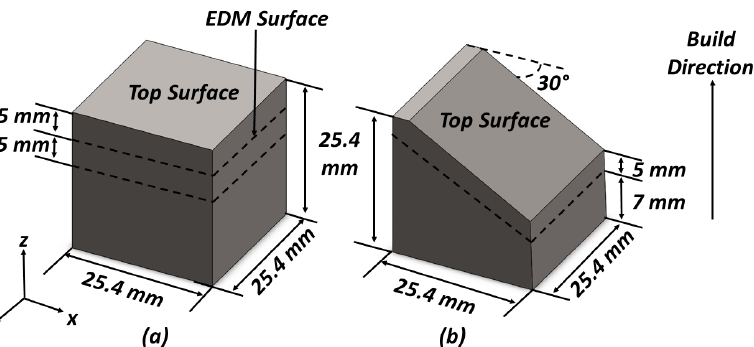
Figure 1. Schematic of the samples: ( a ) Sample 1 and ( b ) Sample 2; the dashed lines show the sections cut from the samples for analysis.